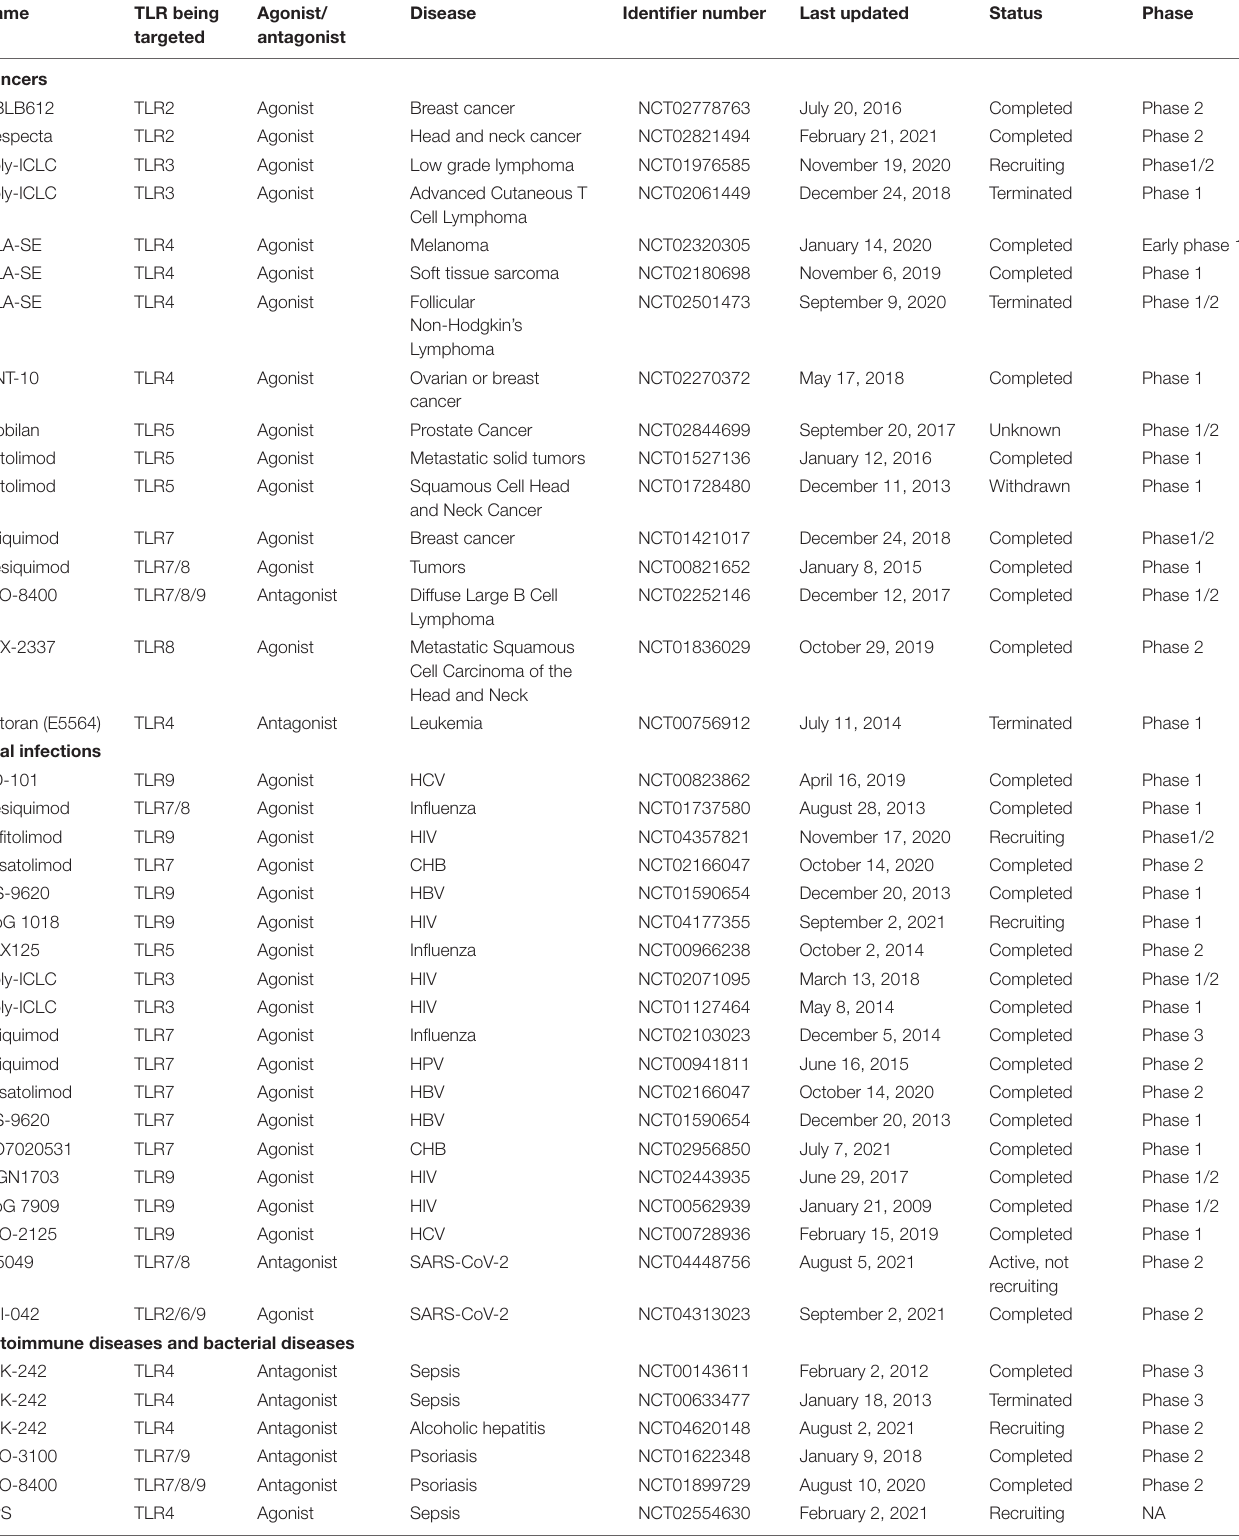
TABLE 1 | TLR-based ligands in clinical